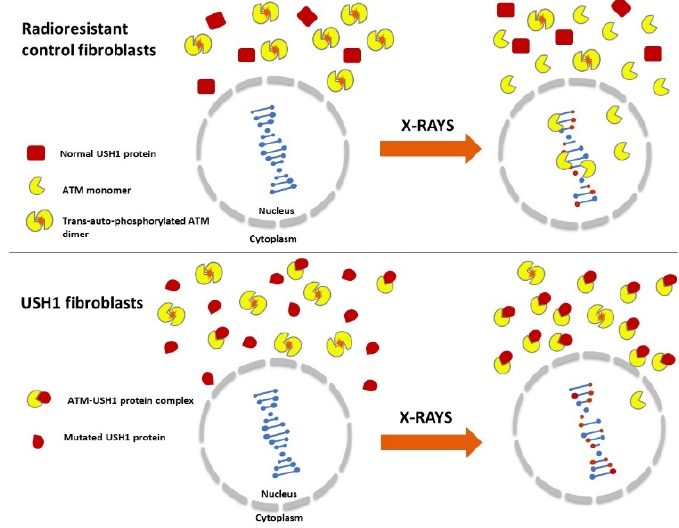
Figure 10. The RIANS model in the USH1 cells: IR induce the monomerization of ATM dimers. The resulting ATM monomers diffuse into the nucleus and participate in DSB recognition via H2AX phosphorylation. In the USH1 cells, USH1 proteins are found to be overexpressed and, as ATM phosphorylation substrates, interact with ATM monomers. The formation of the ATM-USH1 com- plexes prevents the diffusion of a number of ATM monomers in the nucleus, and delays the ATM nucleo-shuttling, leading to a lack of DSB recognition and to the radiosensitivity phenotype of USH1 cells.